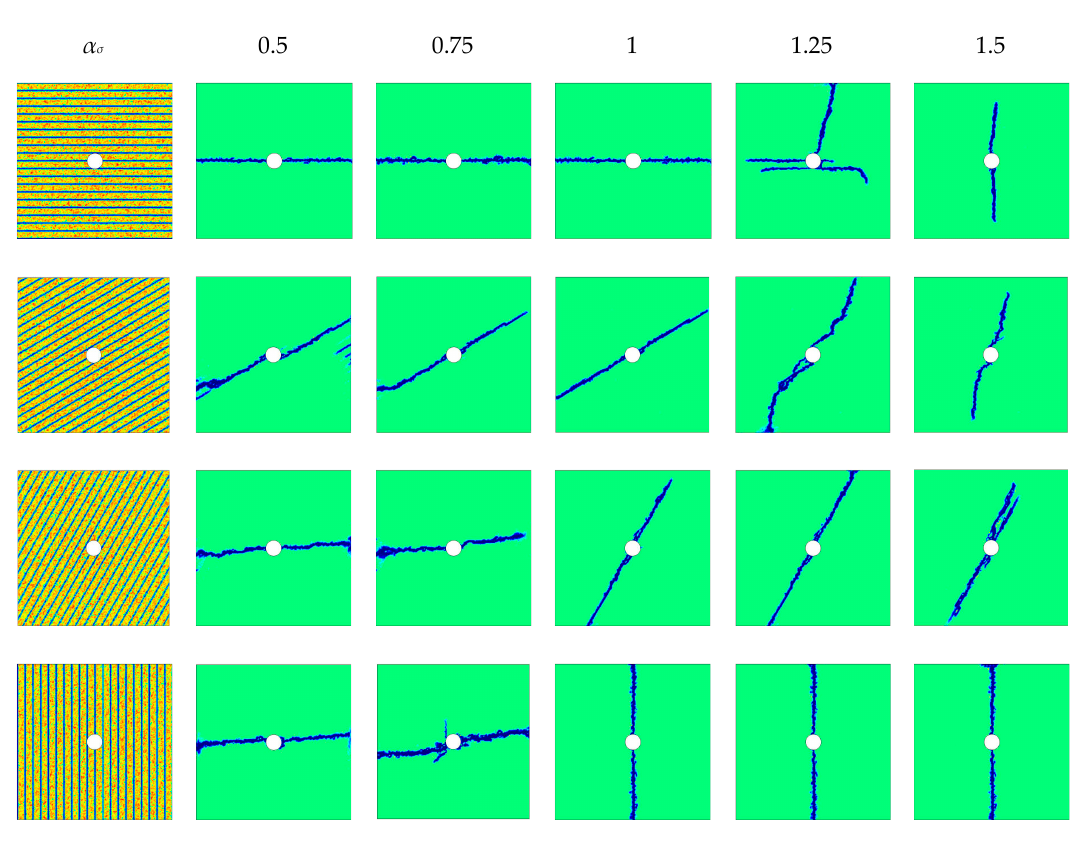
Figure 16. Young’s modulus and fracture network evolution of bedding shale during nitrogen